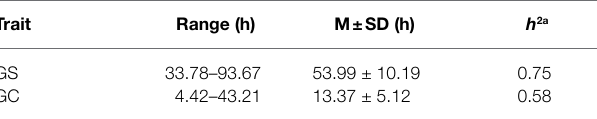
TABLE 1 | Phenotypic performance, variance component, and broad-sense heritability of germination speed (GS) and germination consistency (GC).